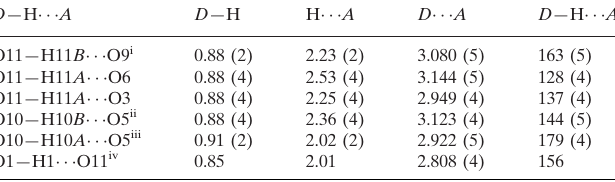
Hydrogen-bond geometry (A˚ , (cid:4)